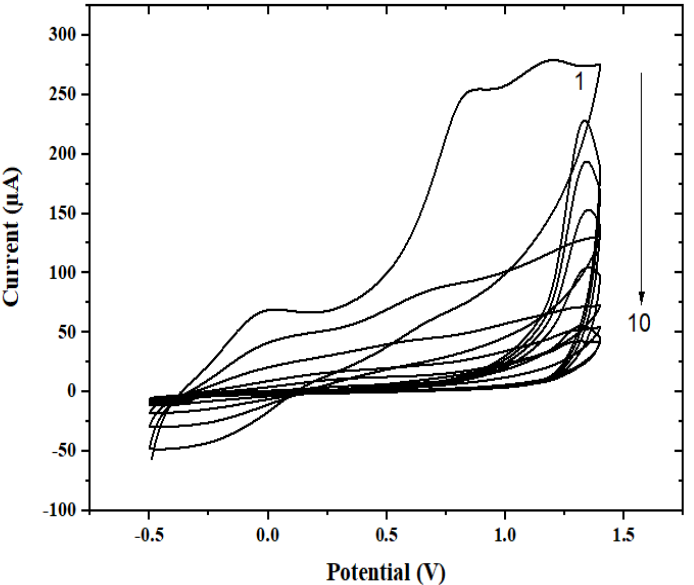
Figure 2. SEM images of the ( A ) GCE, ( B ) GCE/PPy, ( C ) GCE/PPy/SDZ, and ( D ) MIP-GCE/OPPy.